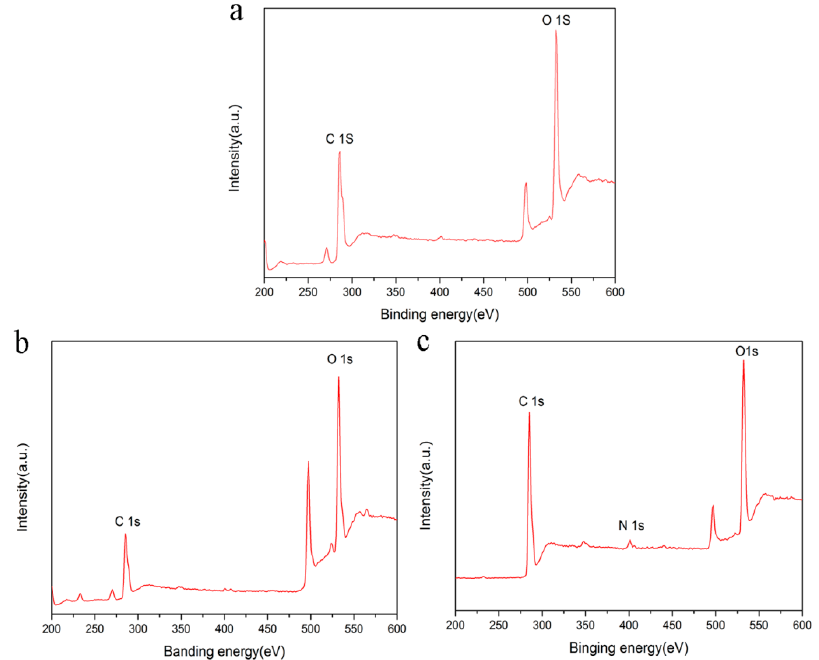
Figure 2. X-ray photoelectron spectroscopy (XPS) survey spectra of the as-synthesized carbon nanomaterials in this work: ( a ) Carbon nanomaterials-1; ( b ) Carbon nanomaterials-2; ( c ) Carbon nanomaterials-3.